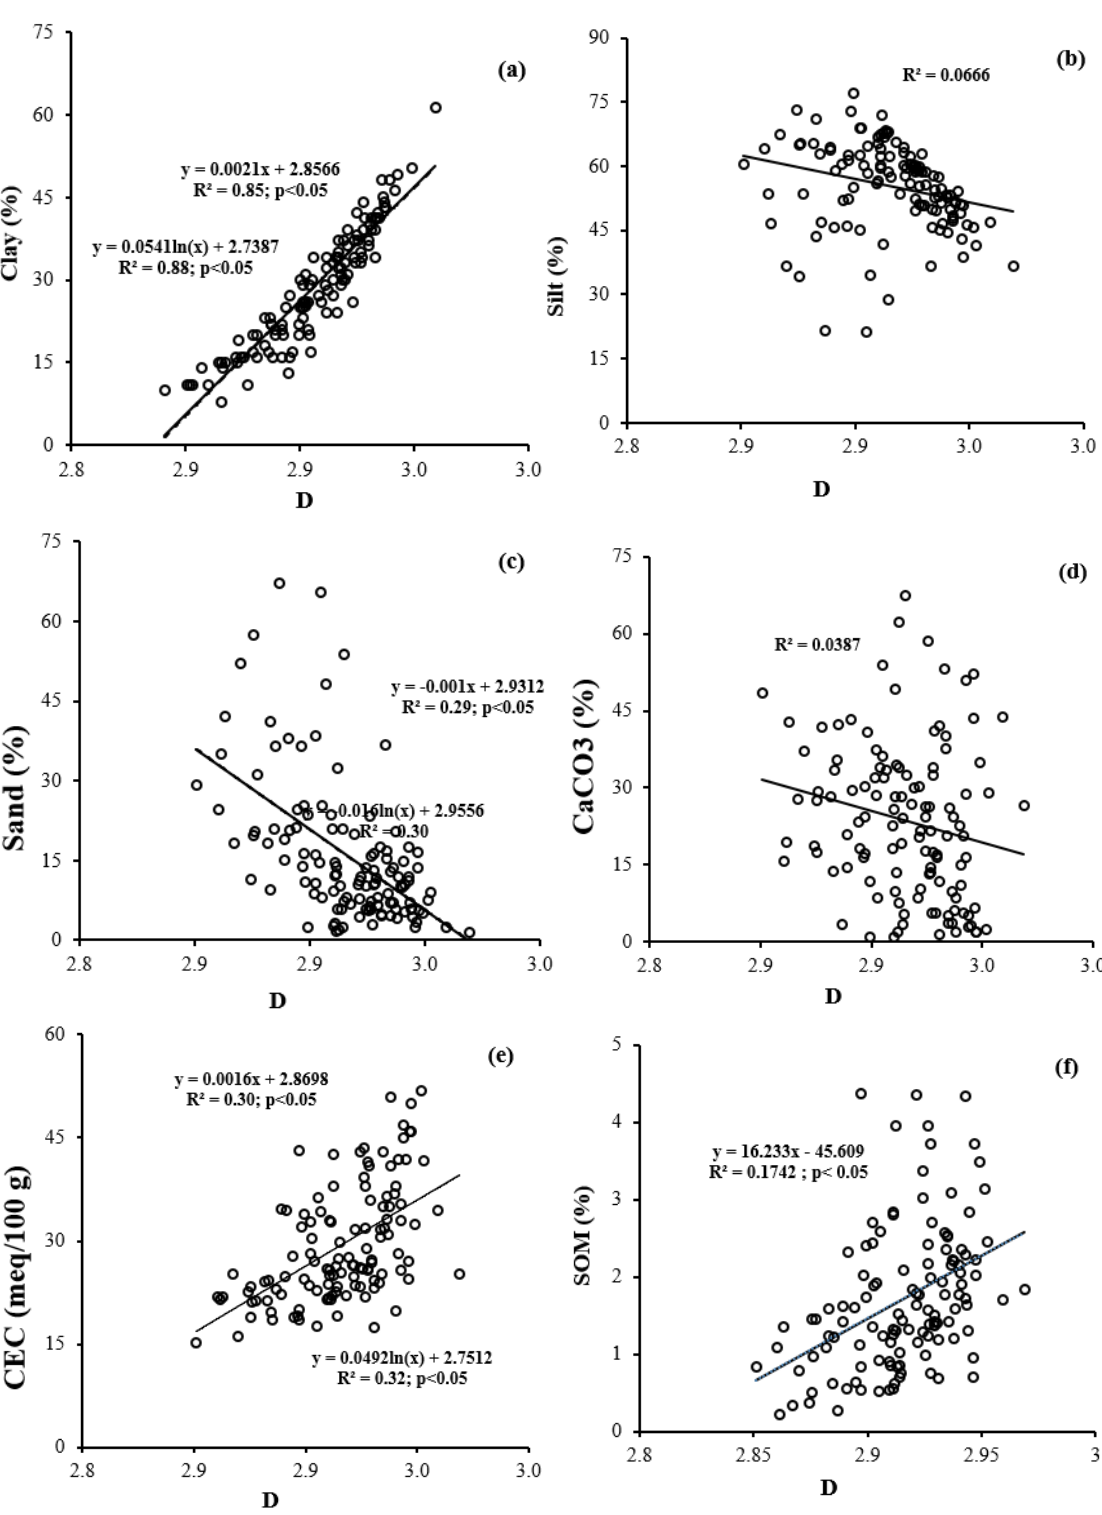
Figure 3. Relationship between fractal dimension (D) and soil properties, a) clay (%), b) silt (%), c) sand (%), d) CaCO3 (%), e) CEC (meq/100g) and f) SOM (%). The clay particles constitute the reactive fractions of the soil, whereas the sand and silt are relatively inert [34]. However, the relationship of silt content with the D of soil PSD is not significant (R 2 = 0.06), while sand content has a strong negative, but slightly non- linear, relationship with the D of soil PSD (R 2 = 0.30) compared to the linear relationship (R 2 = 0.29). Similarly, Su et al. [14], Zhao et al. [35], Zhao et al. [5], Deng et al. [3], Li et al. [20] and Omidvar [11] all demonstrated a negative relationship between D of soil PSD values and sand content. Unlike our results, Deng et al. [3] and Peng et al. [2] reported a positive relationship between silt content and the D of soil PSD. SOM content also shows a positive non-linear relationship with the D of soil PSD (R 2 = 0.32) while there is no clear relationship between CaCO 3 and the D of soil PSD (Figure 3d); however, as previously mentioned, CaCO 3 was positively correlated with SOM (r = 0.26, Table 2). The D of soil PSD increased with increasing CEC and SOM, but in non-linear (R 2 = 0.32) and linear re- lationships (R 2 = 0.17), respectively. 3.3. Fractal Dimension and Land Use Silty clay loam had the highest cumulative fraction among the six different textural classes followed by silt loam and silty clay loam (Figure 4a). The sandy loam soil class had